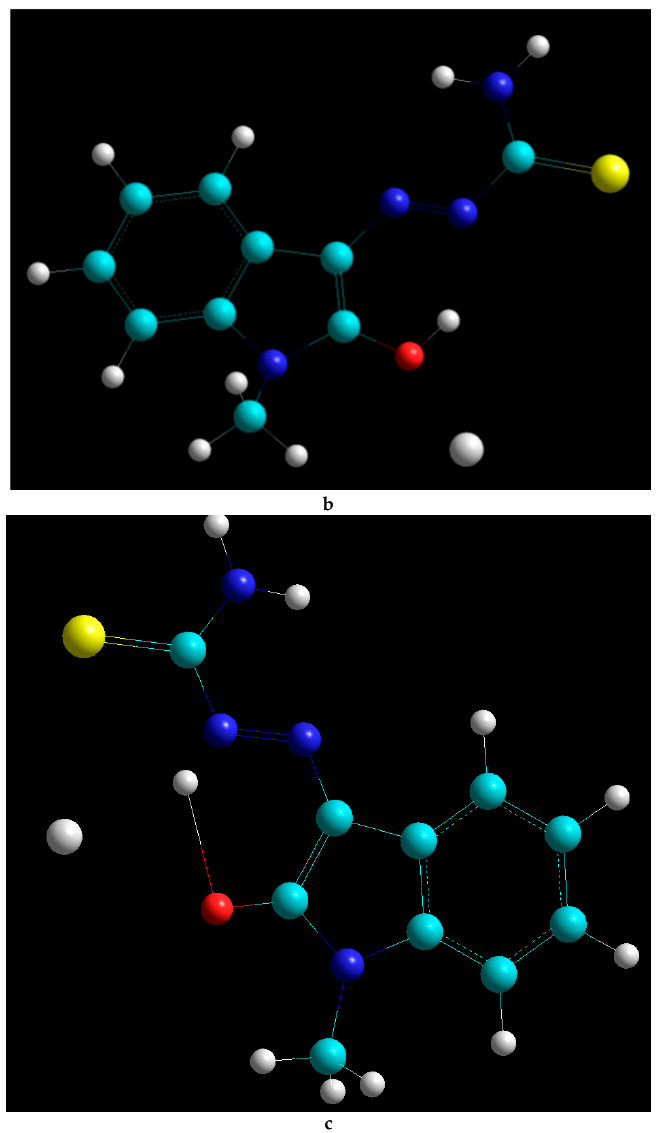
Figure 7. HyperChem representation of ( a ) Methisazone–Ca, ( b ) Methisazone–Zn, and ( c ) Methisazone–Mn. Molecular graphics and analyses performed with HyperChem, HyperCube Inc, USA. Color interpretation in the Figure: Light Blue/ Cyan for Carbon, Deep Blue for Nitrogen, White for Hydrogen Red for Oxygen, Yellow for Sulfur, White (larger atom) for Metals.